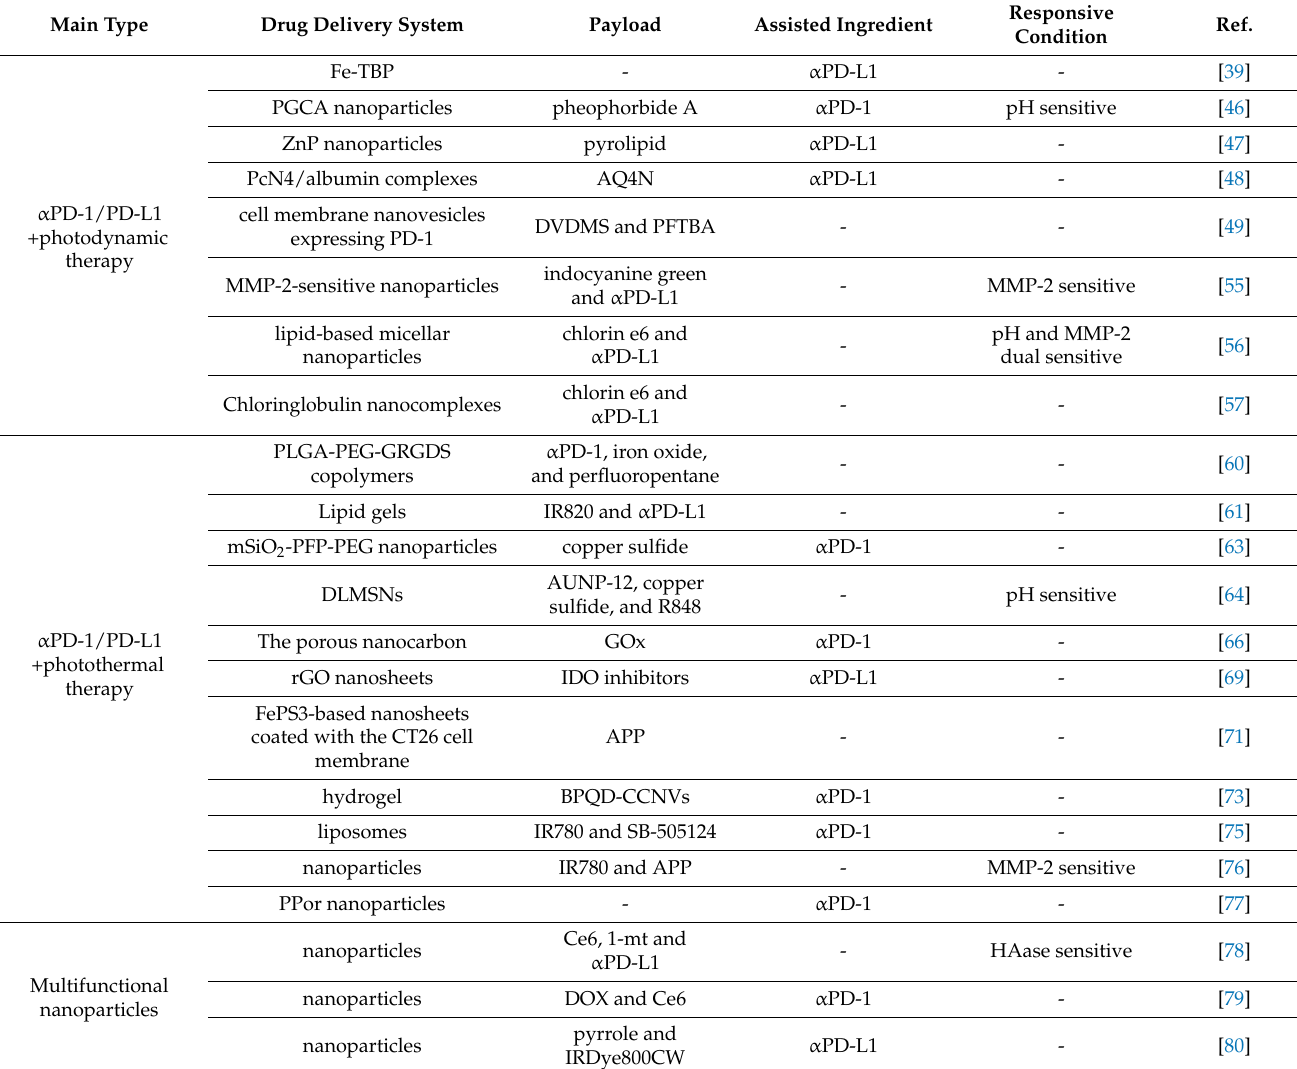
Table 1. Summary of novel nanoplatforms including PDT, PTT and multifunctional